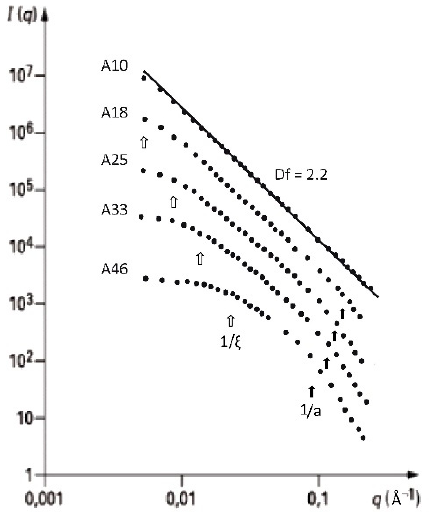
Figure 4. I(q) as measured by SANS for the acid set (from [32]) . Table 1. Aerogel bulk density versus the TMOS content for the base, neutral and acidic catalysis. Bulk Density (g·cm − 3 TMOS (vol. %)